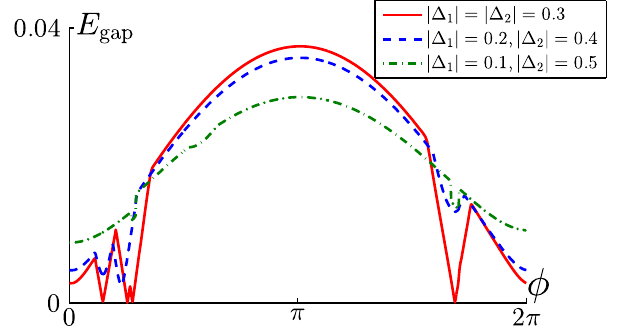
FIG. 6. The bulk gap calculated along a cut in Fig. 5 with 0 . 6 . When j Δ Δ 0 . 3 , the system is in the BDI E 1 j ¼ j 2 j ¼ Z;J ¼ symmetry class. The bulk gap closes when the system undergoes topological phase transitions between regions with different (odd) Z indices. When j Δ ≠ j Δ 1 j 2 j , the effective time-reversal sym- metry is broken, and the bulk becomes gapped for all values of ϕ